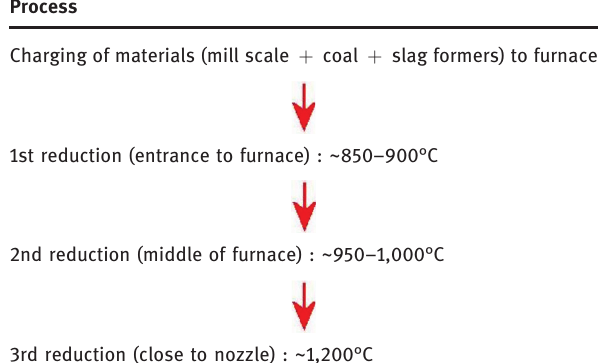
Table 4: The flow of reduction in the rotating furnace used. Process